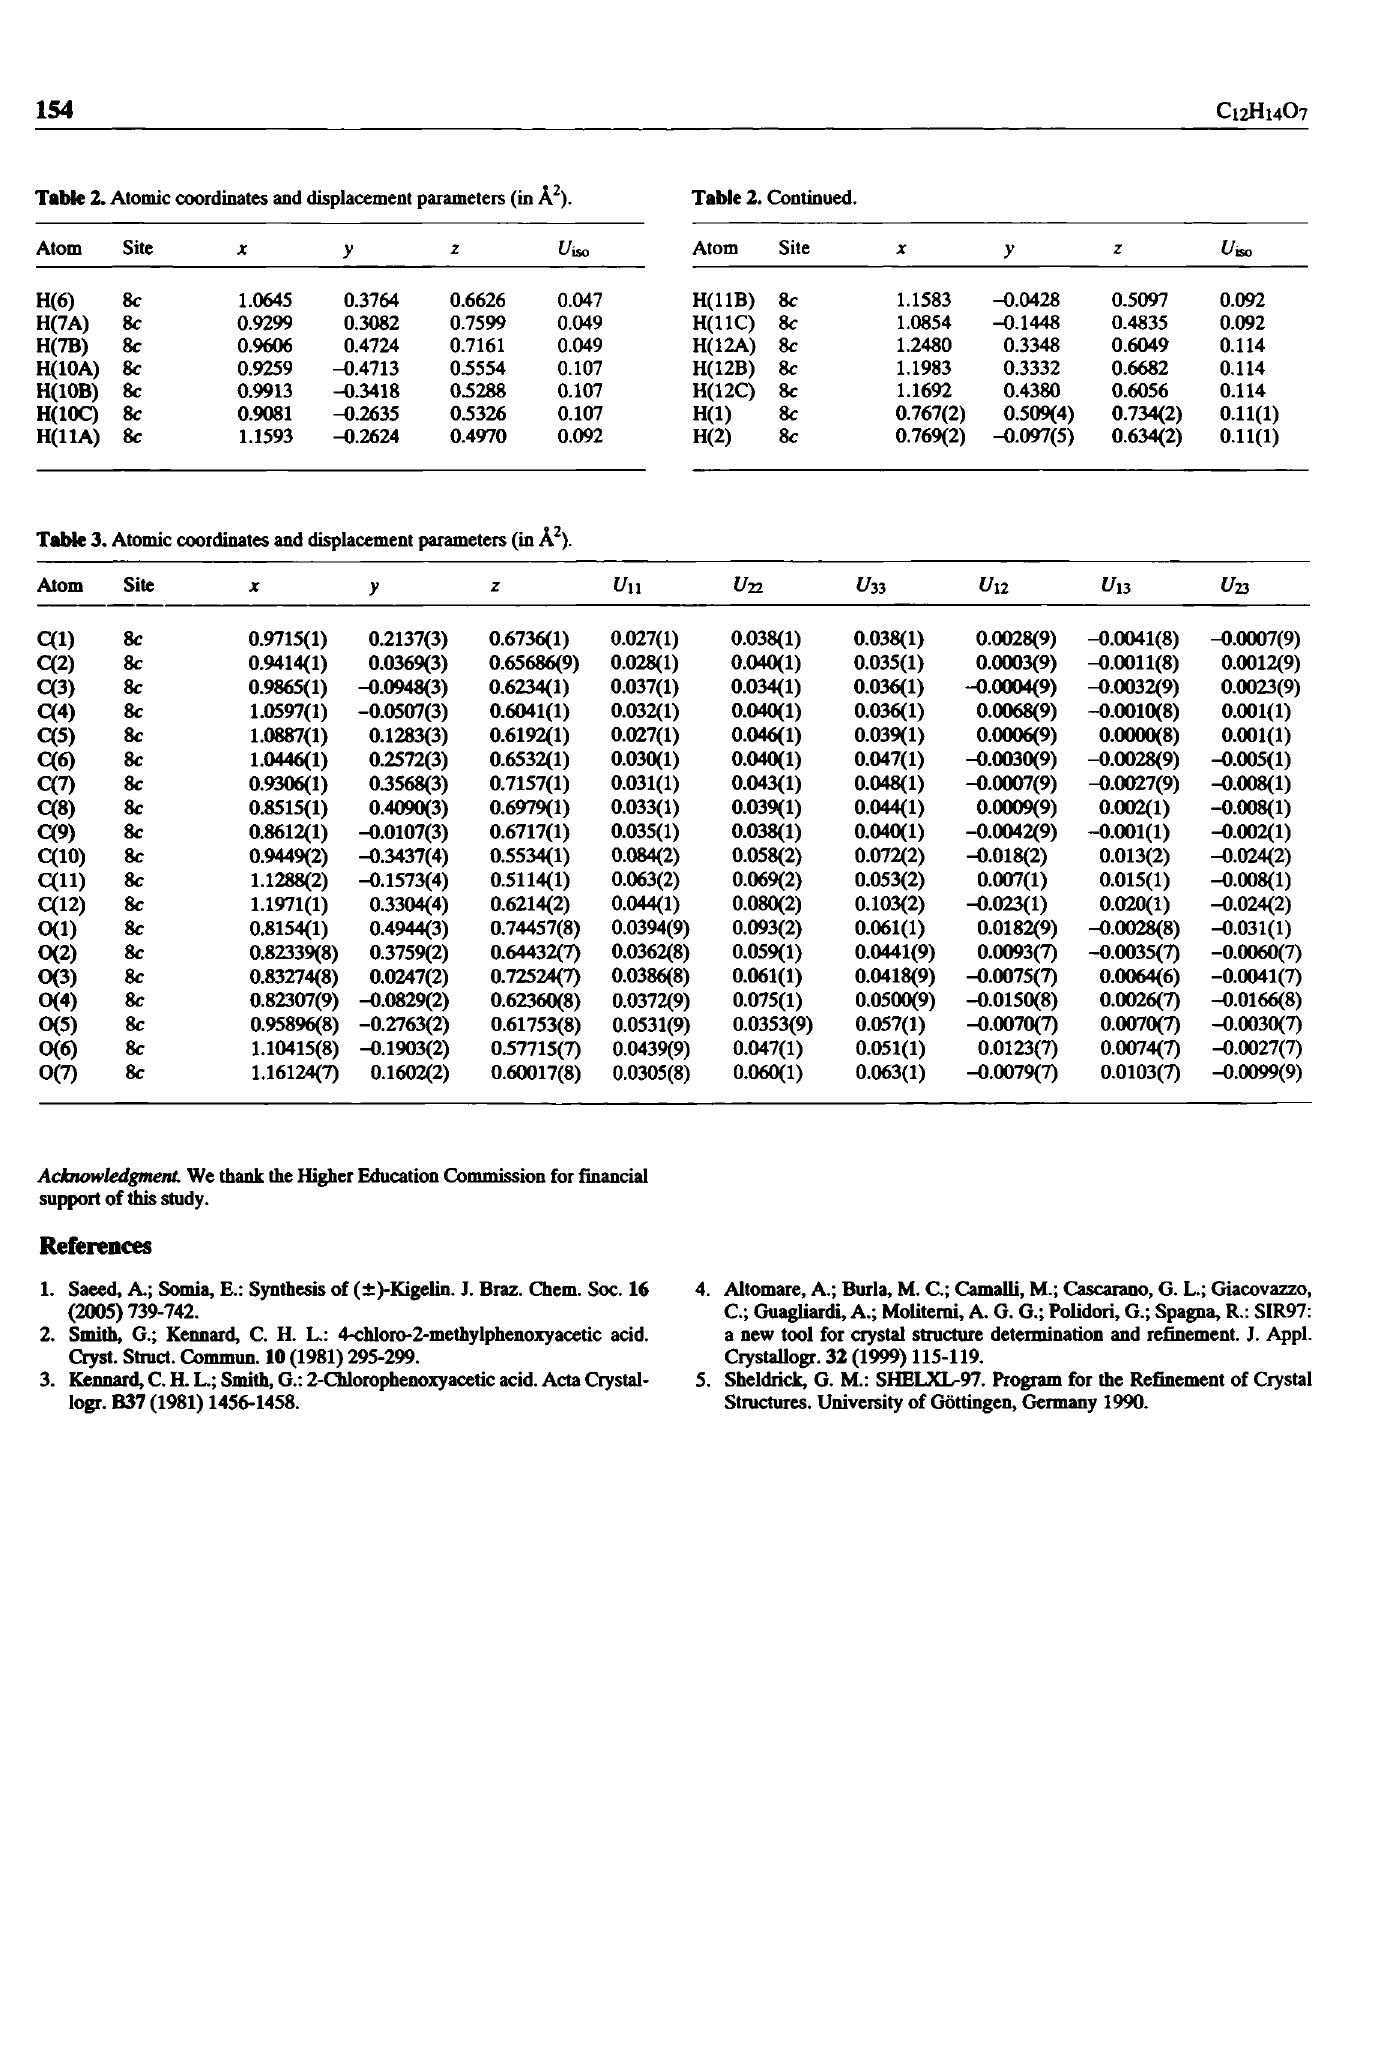
Table 3. Atomic coordinates and displacement parameters (in A 2